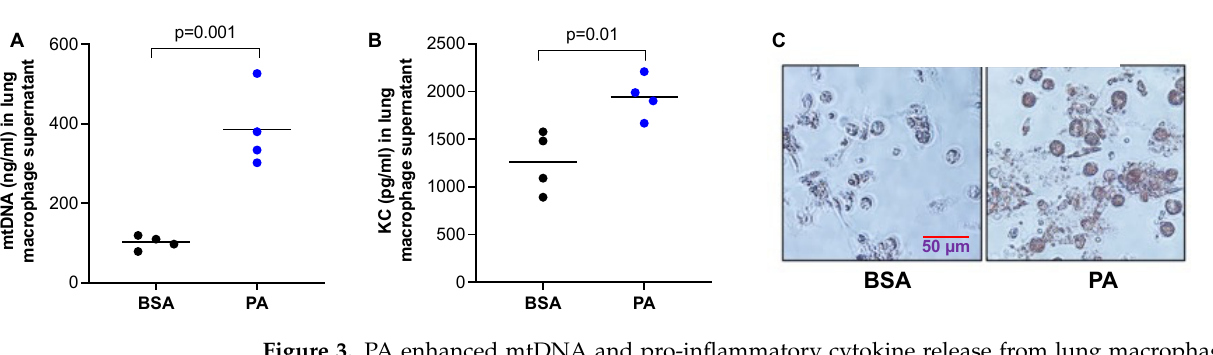
Figure 2. PA promoted lung inflammatory responses in mice. Wild-type BALB/c mice were treated oropharyngeally with PA prepared in BSA or BSA (control) for 24 h to obtain BALF. ( A ) Neutrophil count in BALF; ( B ) Neutrophil chemoattractant LIX levels in BALF; ( C ) Macrophage count in BALF; ( D ) mtDNA levels in BALF; ( E ) DNase activity levels in BALF. n = 5 to 7 mice per group.